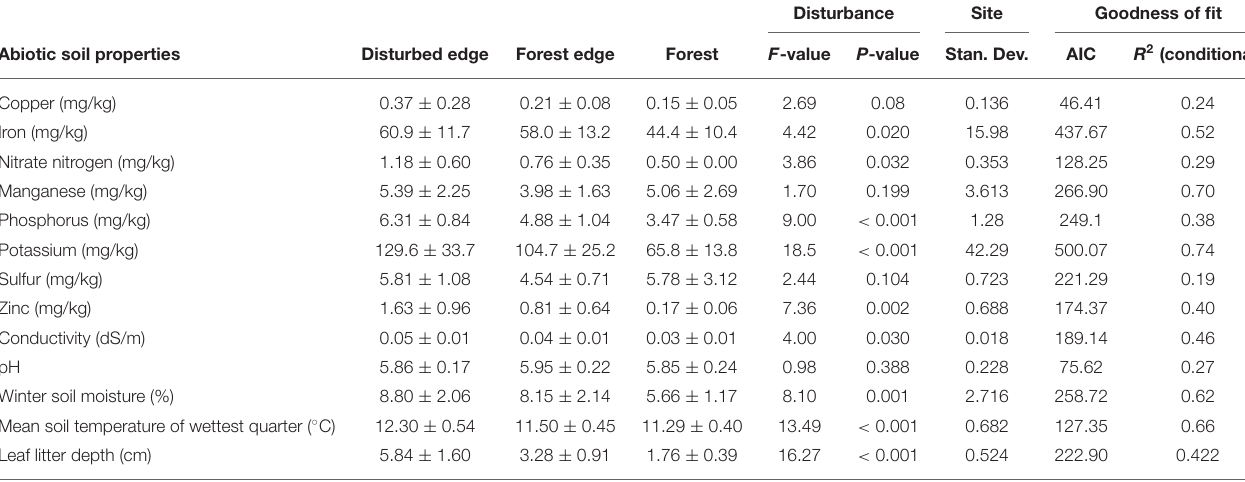
TABLE 1 | Abiotic soil properties across seventeen sites in southwest Western Australia along a disturbance gradient.